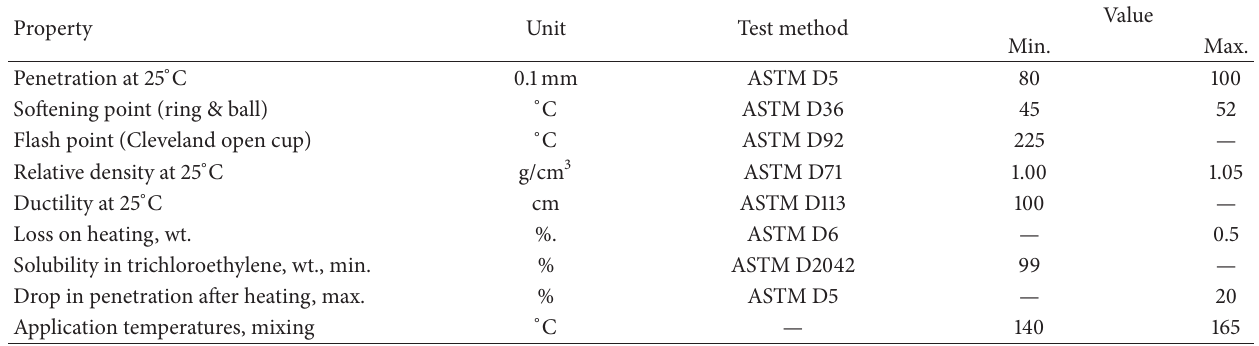
Table 2: Specification of bitumen 80/100 penetration used in this study.